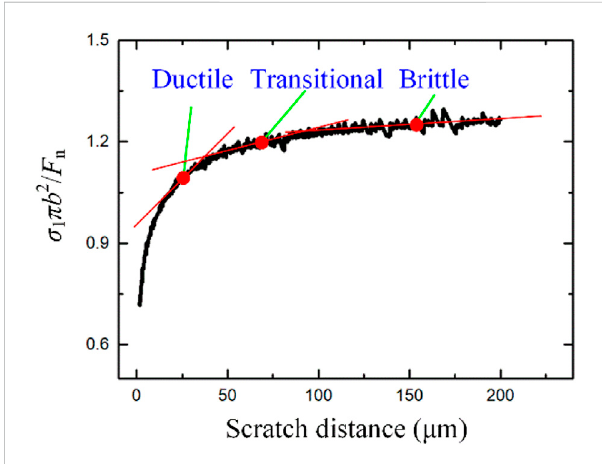
FIGURE 7 The normalized stress distribution along the scratch